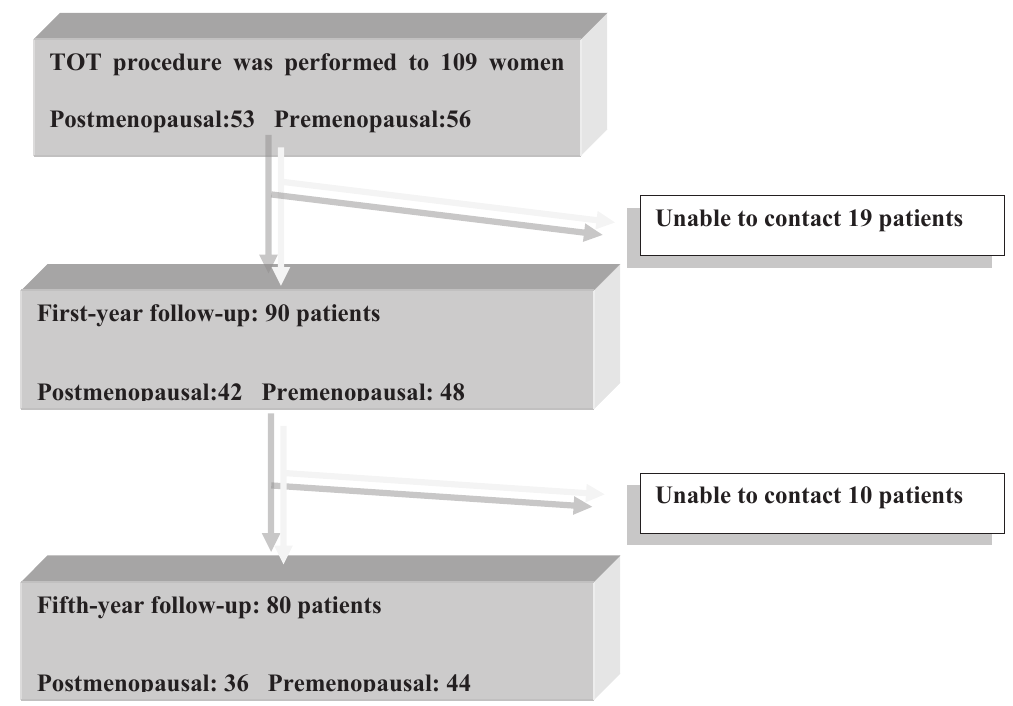
Figure 1 - The first-year and fifth-year distribution of the patients that underwent TOT surgery.